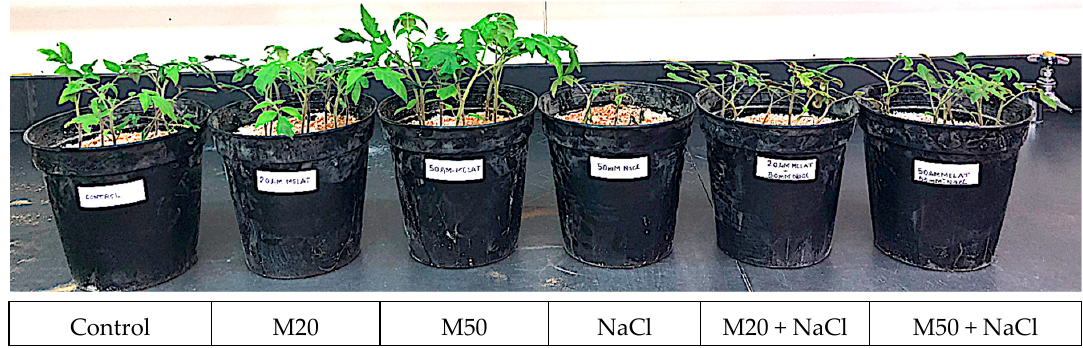
Figure 1. Growth performance of tomato seedlings under melatonin and salinity conditions.